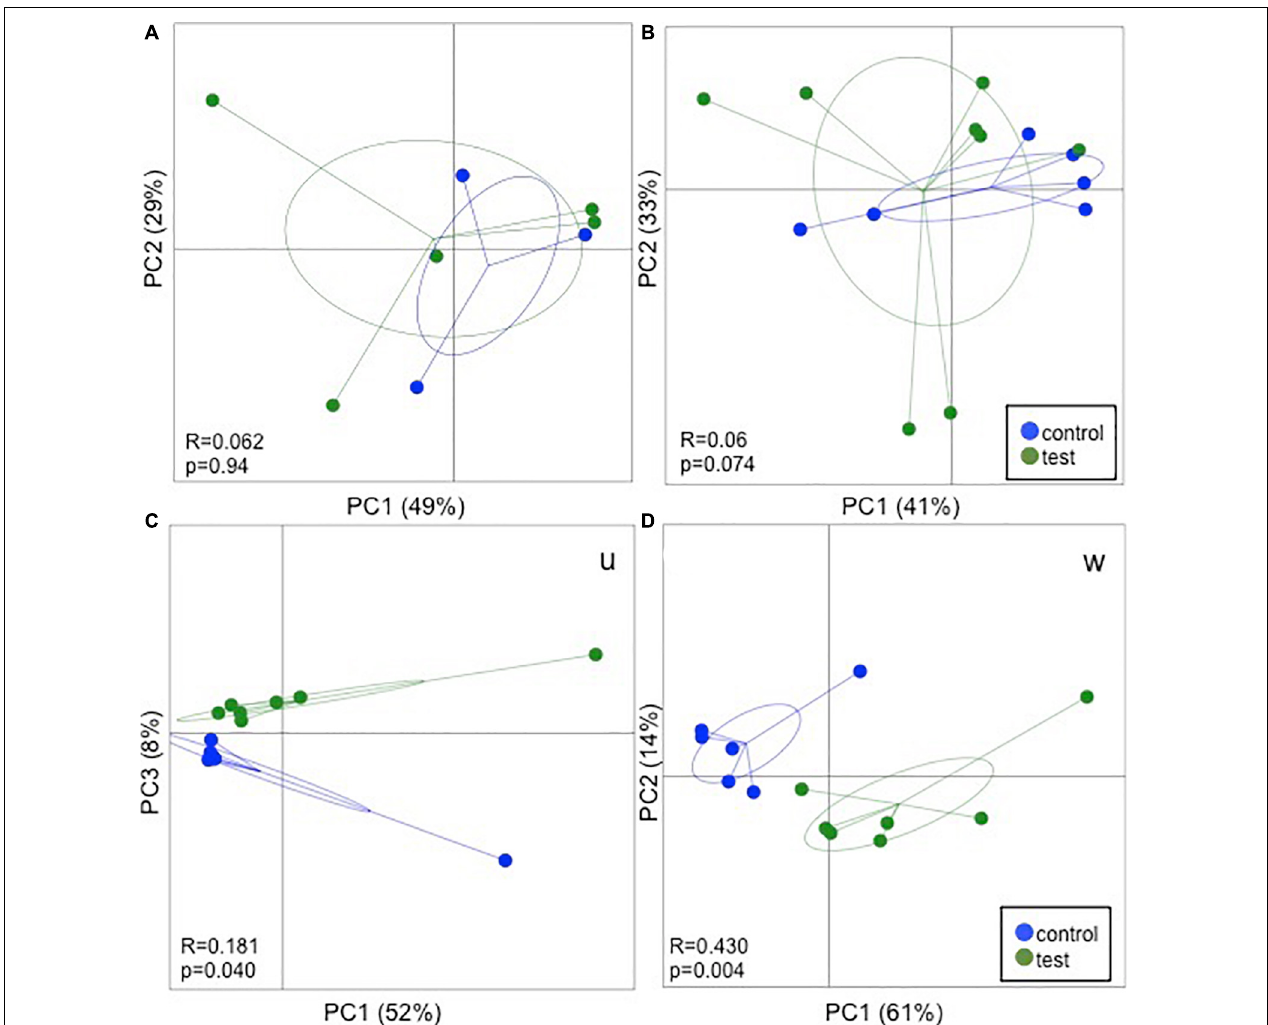
FIGURE 2 | 16S rRNA gene amplicon sequencing results fecal samples from foals fed either a test supplement enriched with oligosaccharides or a control diet at Day 1 (A) , Day 7 (B) , and Day 49 (C,D) post parturition. Principal coordinates analysis (PCoA) plots based on weighted UniFrac distance matrices show no clear separation due to the treatment on Day 1 and 7. On Day 49 significant differences were observed in both unweighted (U) and weighted (W) UniFrac distance. ANOSIM results are presented in the bottom left corner of each plot.